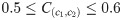
Performance comparison for REMAP (green), PRW (blue), and NRLMF (orange).NT3 (3 or more known targets per chemical) datasets used for varying number of ligands (A) and chemical structural similarity (B). Performance measurement explained in the measuring prediction accuracy of REMAP by TPR vs. cutoff rank section. (A) Performance comparison on the datasets with varying number of ligands per protein. For example, the x-axis of L21more means that the proteins of interest have 21 or more known chemicals to bind. (B) Performance comparison on the datasets with the ranges of chemical structural similarity of the tested chemicals to the trained chemicals. For instance, the x-axis of Tc0.5to0.6 means that for the tested chemicals, at least one trained chemical was found such that 0.5≤C(c1,c2)≤0.6 and no trained chemical was found in greater similarity than 0.6. All TPR values are based on 10-fold cross validation. Error bars represents s.e.m. Asterisks represents statistical significance based one t-test of the 10 TPR values (* for p < 0.05, ** for p < 0.001).